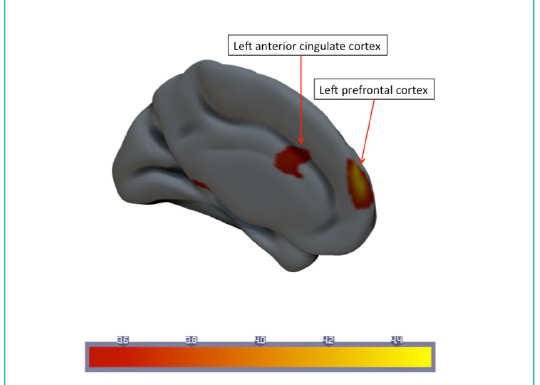
Figure 1: Statistical parametric map of longitudinal changes in mean cerebral blood flow (CBF) in the responder group. Downreg- ulation of cortical CBF in the left prefrontal cortex and anterior cin- gulate